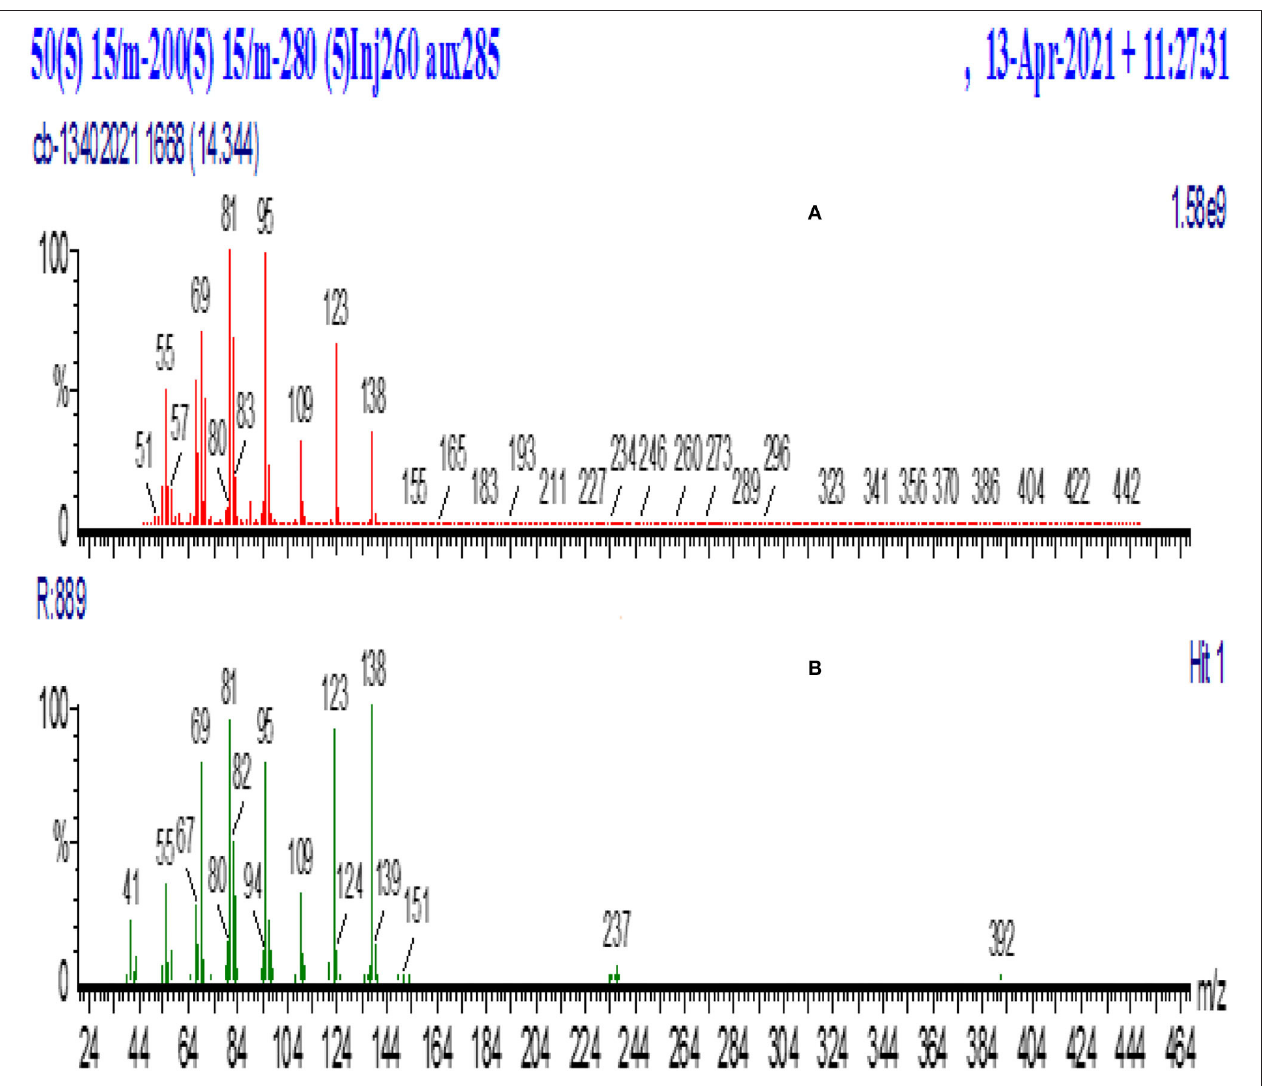
FIGURE 3 | GC-MS spectra of peak (B) identified as citronellyl butyrate and its confirmation in this study. (A) Synthesized, (B)